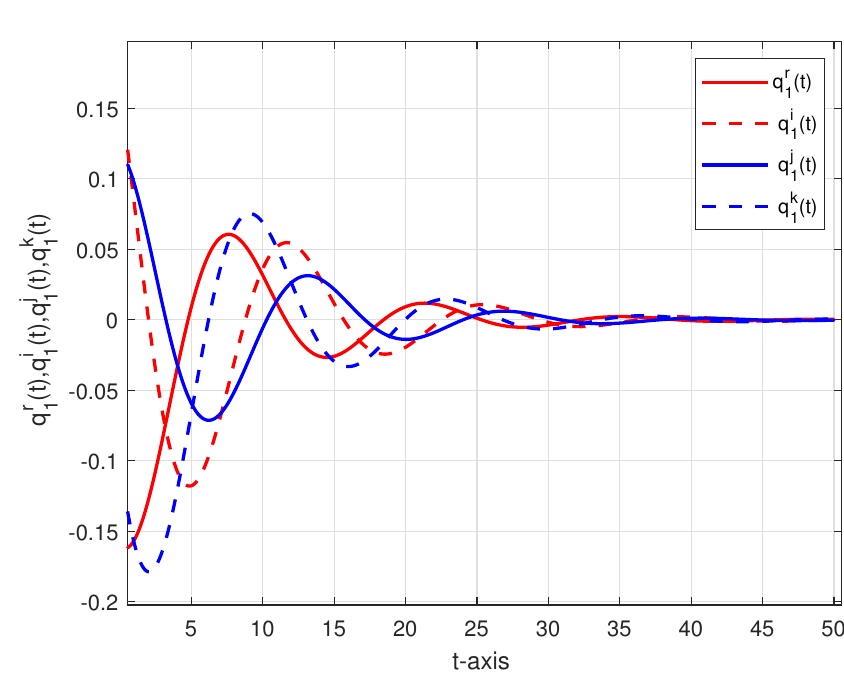
Figure 3. State trajectory of four parts of q 1 ( t ) for system (26).